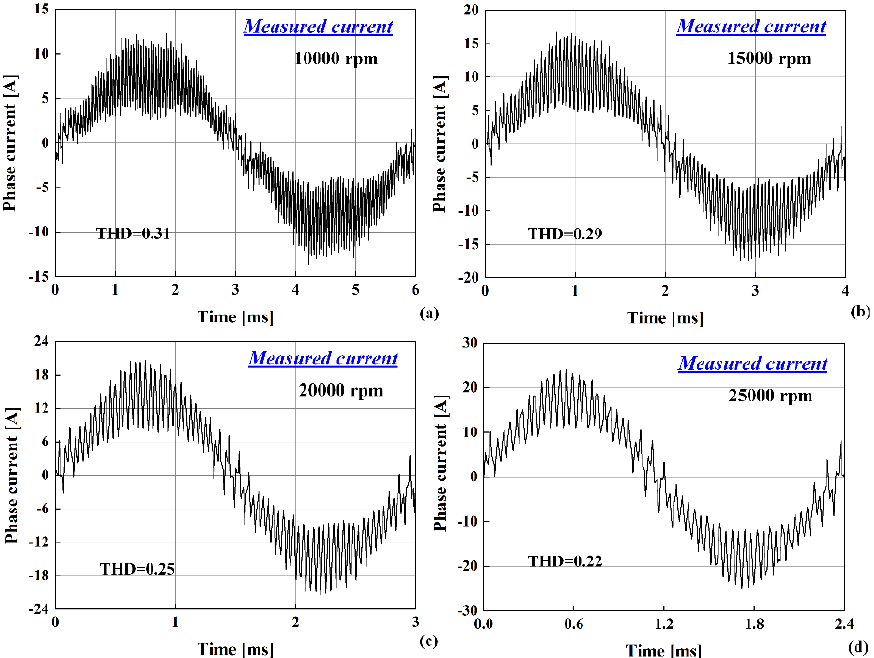
Figure 15. Measured input current under load conditions: ( a ) 10,000 rpm, ( b ) 15,000 rpm, ( c ) 20,000 rpm, ( d ) 25,000 rpm. Table 4. Measurement results of input power, output, mechanical loss, and electromagnetic loss.